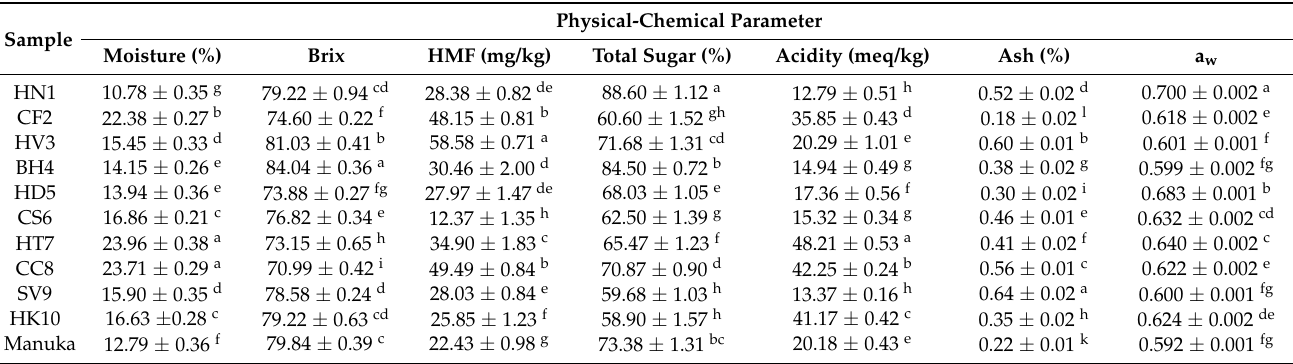
Table 4. Physical-chemical parameters of the honey